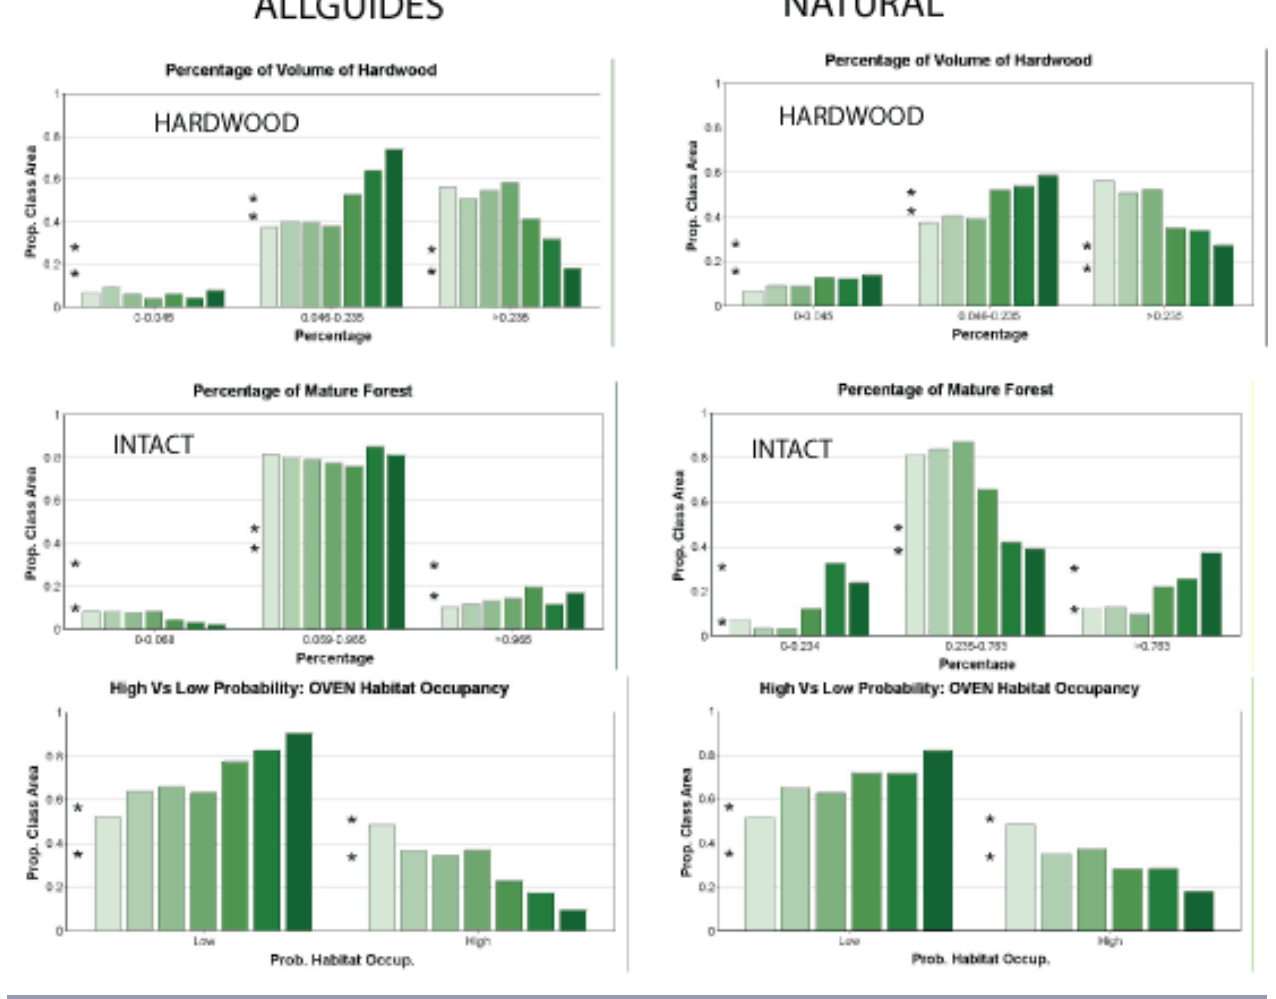
Fig. 14. Changes in hardwood (HARDWOOD), intact forest matrix (INTACT), and Ovenbird habitat, for ALLGUIDES and NATURAL scenarios, over years 0, 10, 20, 50, 100, and 150 (light to dark green